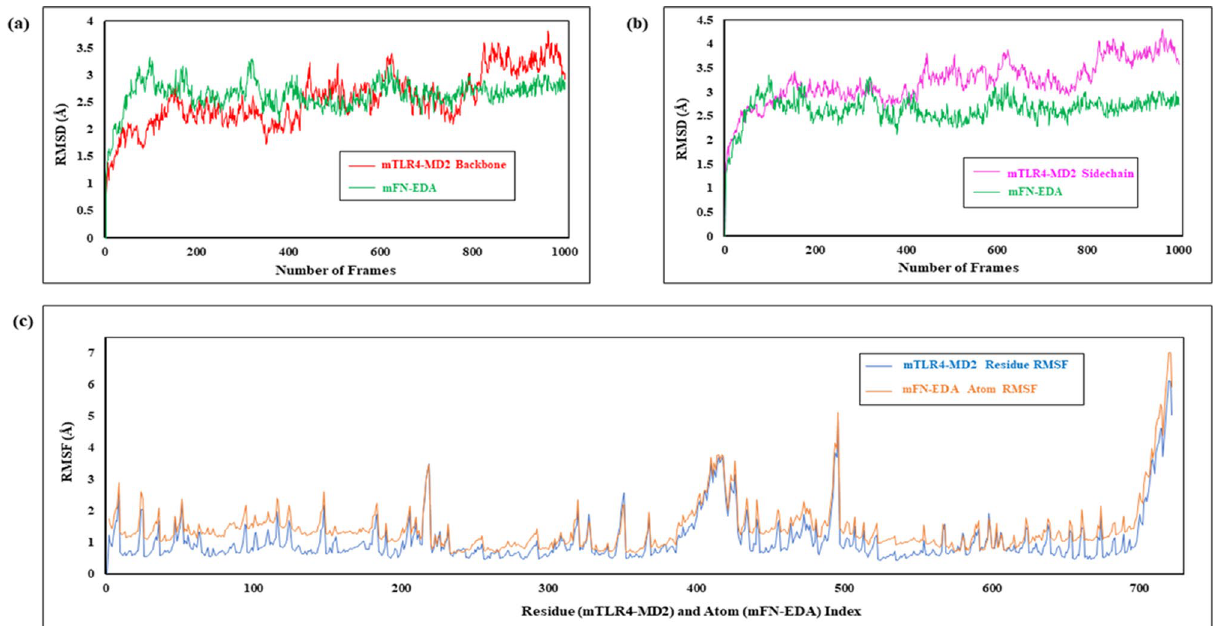
Figure 5. RMSD and RMSF plots of mouse TLR4-MD2-FN-EDA using Desmond Simulation Interactions Diagram. ( a ) TLR4-MD2 Backbone RMSD plot with FN-EDA; ( b ) TLR4-MD2 Sidechain RMSD plot with FN-EDA; ( c ) Backbone RMSF